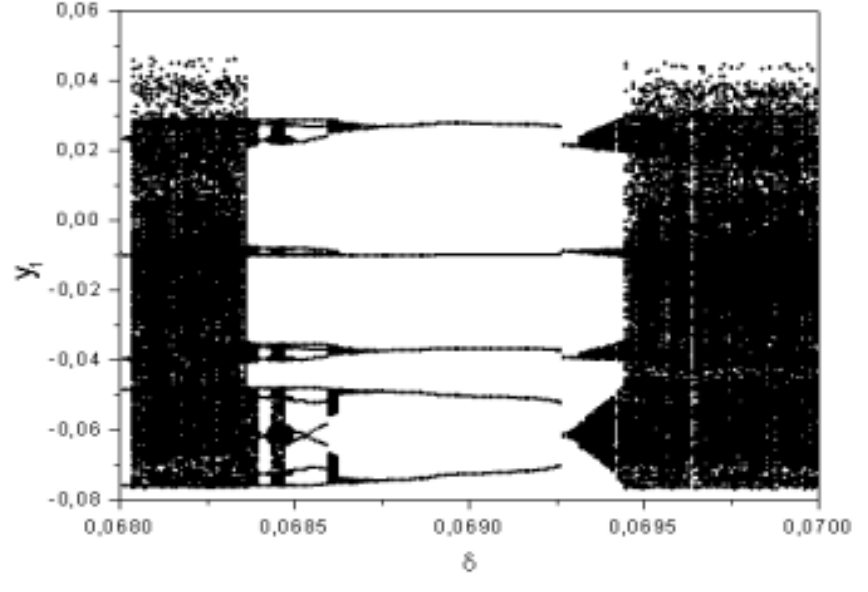
Fig. 7. Periodic window at the interval 0 . 068 (cid:1) δ (cid:1) 0 . 070 for θ = 0 . 7